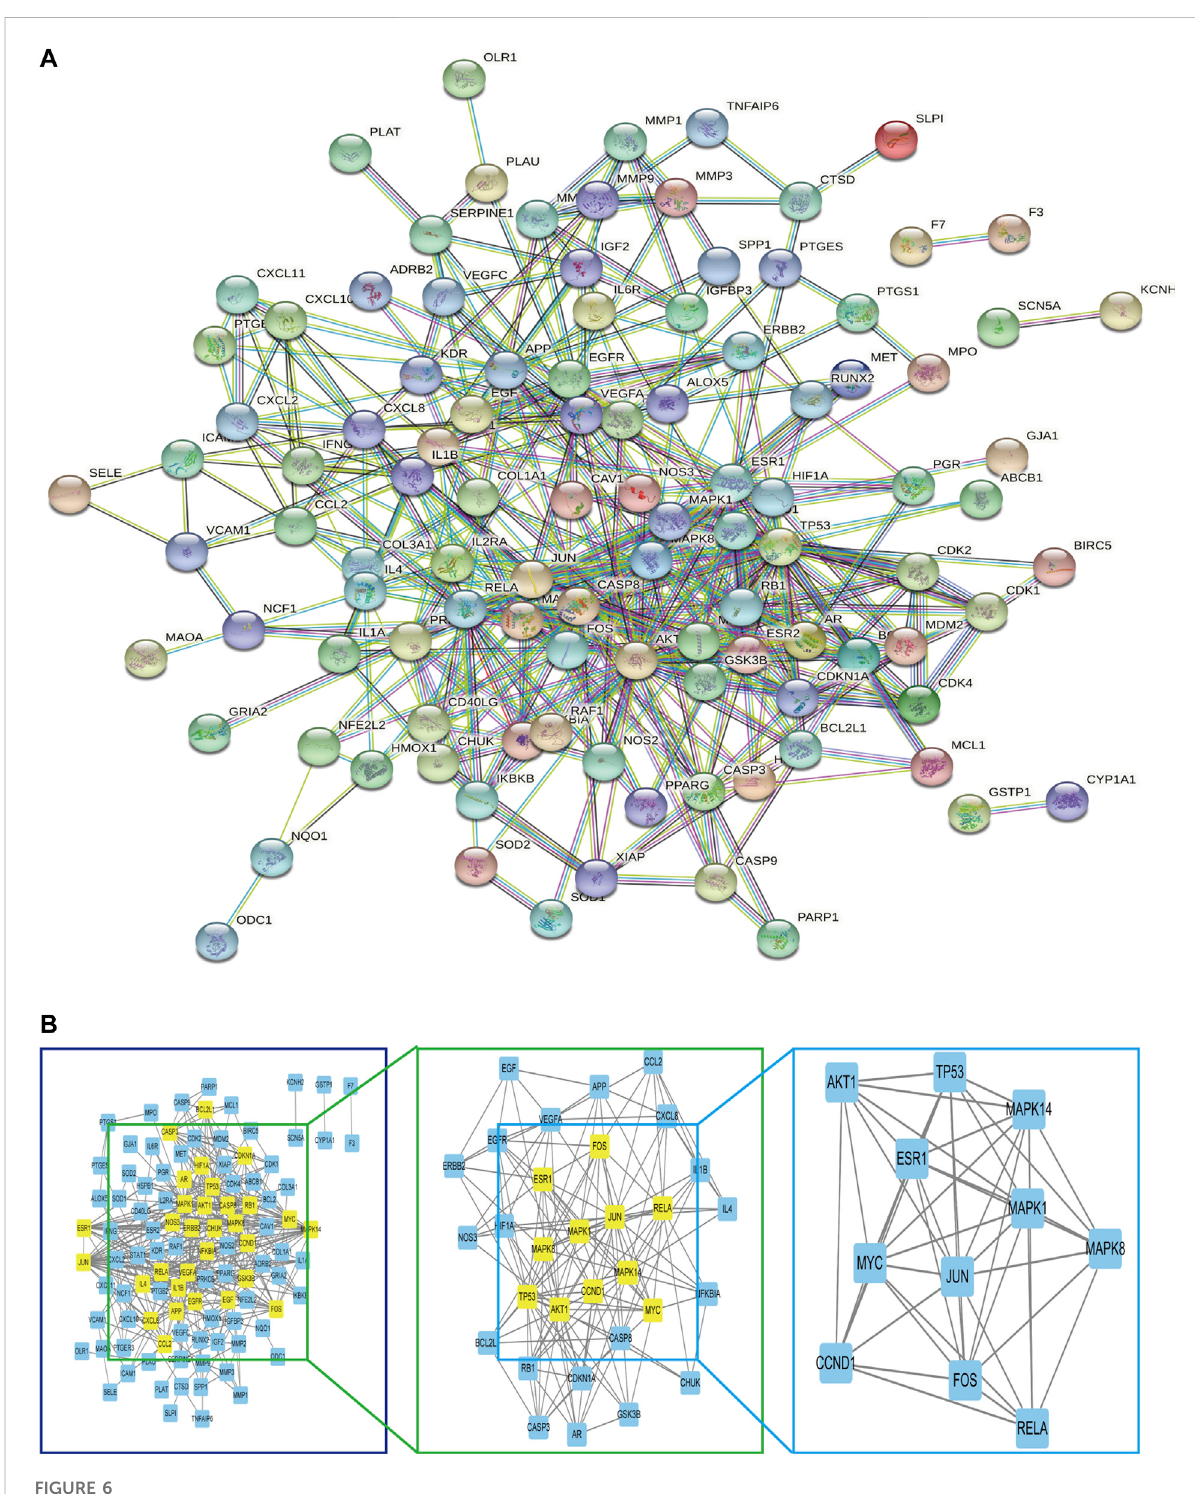
FIGURE 6 (A) Construction of the PPI network. (B) Hub genes of (A) annua for the treatment of